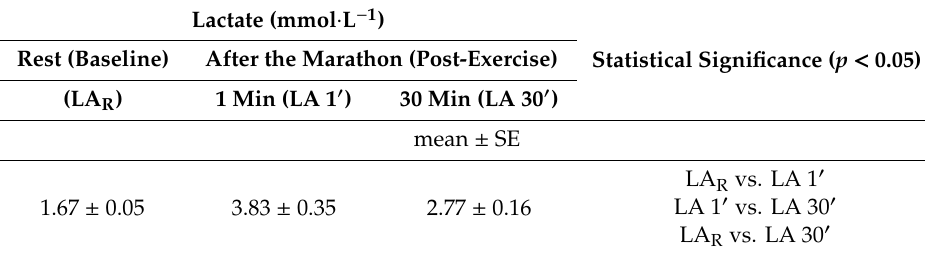
Table 3. Lactate level changes before and after the end of the marathon.